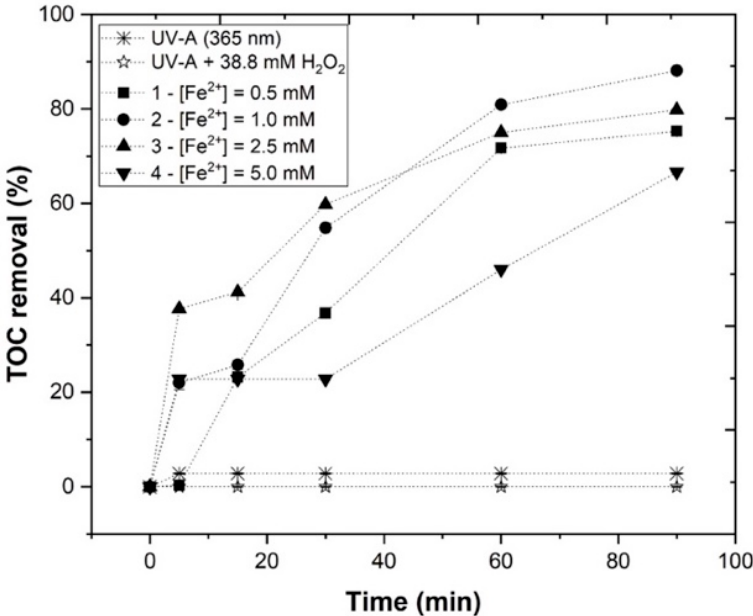
Figure 10. Progress of TOC percentage removal at different Fe 2+ concentrations (0.5–5.0 mM) in the UV-A-Fenton process. Experimental conditions: [H 2 O 2 ] = 38.8 mM, pH = 3.0, agitation = 350 rpm, T = 25 °C, radiation= UV-A, I UV = 32.7 Wm − 2 , t = 90 min. Blank non-catalytic experiments (UV-A/H 2 O 2 and UV-A without H 2 O 2 ) are also represented as a reference.